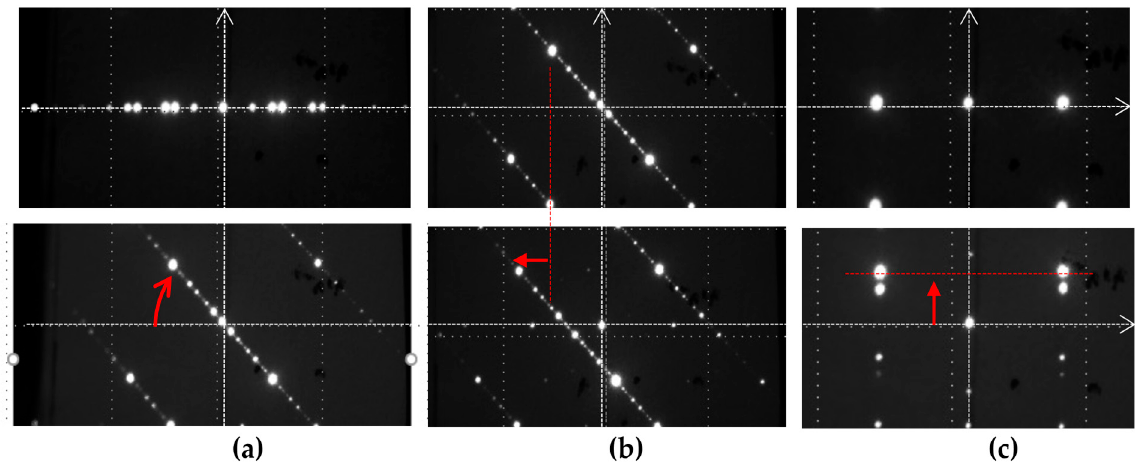
Figure 6. CGH calculation algorithm for beam steering with two points. ( a ) Clockwise rotation. ( b ) Linear shift along the x- and y-directions.